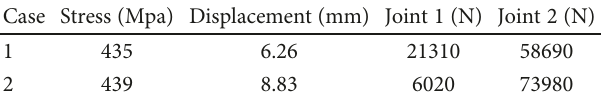
Table 2: Comparison of two cases.